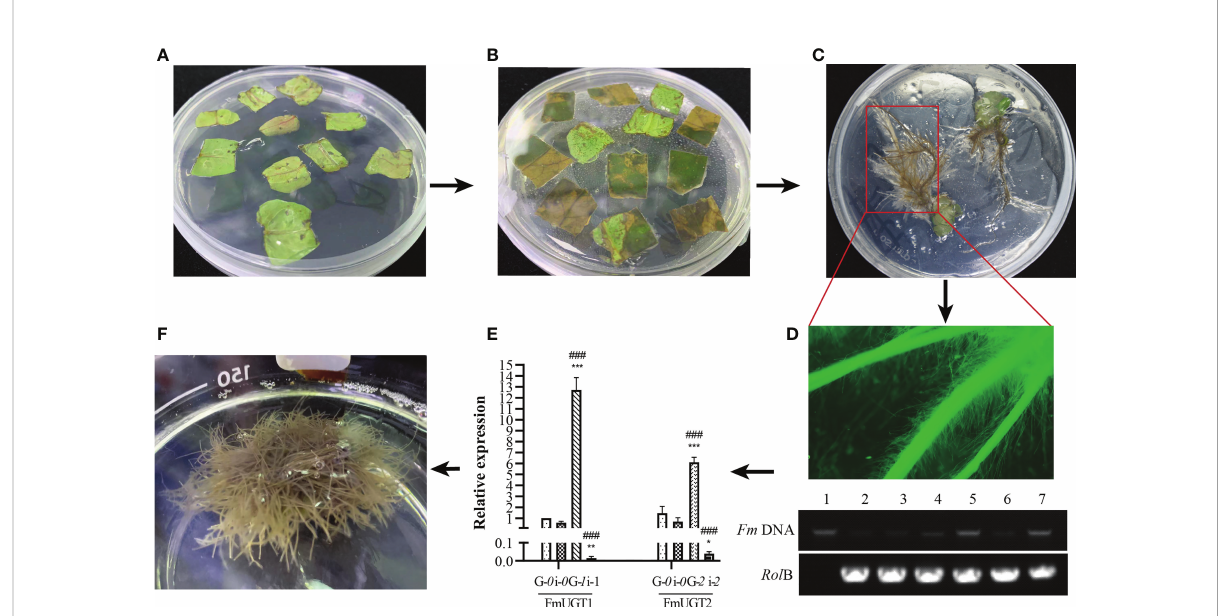
FIGURE 5 The process of transgenic hairy roots construction. (A) Preculture of the detached F multi fl ora leaves. (B) Continued culture of the detached (F) multi fl ora leaves after C58C1 infection. (C) Hairy roots grew at the leaf margins. (D) Identi fi cation of the hairy roots. Observation of eGFP protein expression through fl uorescence microscope (top); PCR analysis of the RolB gene (bottom). (E) RT-qPCR analysis of FmUGT1 and FmUGT2 in different groups of transgenic hairy roots. G- 0 : pK7WG2D- 0 ; i- 0 : pK7GWIWG2D- 0 ; G- 1 : pK7WG2D- FmUGT1 ; i- 1 : pK7GWIWG2D- FmUGT1i ; G- 2 : pK7WG2D- FmUGT2 ; i- 2 : pK7GWIWG2D- FmUGT2i . (F) The identi fi ed hairy roots were cultured in MS liquid culture medium. * Indicates a signi fi cant difference between the control groups and OE/RNAi groups at P < 0.05; ** indicates a signi fi cant difference at P < 0.01; and *** indicates a signi fi cant difference at P < 0.001. ### Indicates a signi fi cant difference between the OE groups and RNAi groups at P < 0.001. Every group contained three biological replicates with three technical replicates each. The vertical bar represents mean ± SD (n = 3).